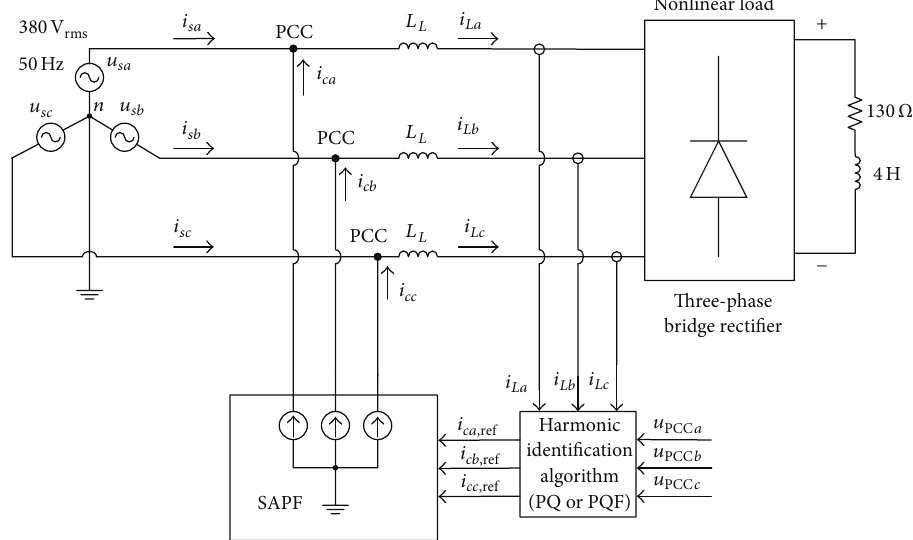
Figure 2: The balanced power system with ideal shunt active power